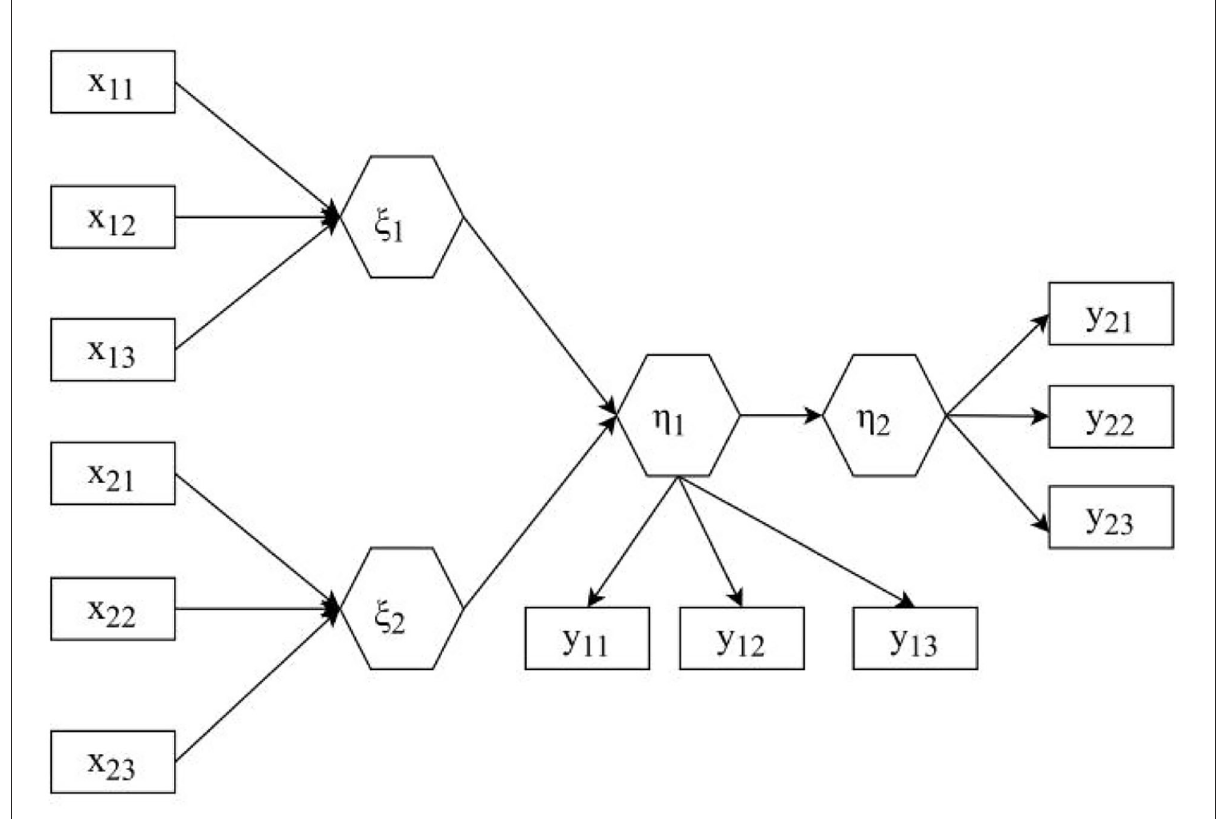
FIGURE1 Structural equation